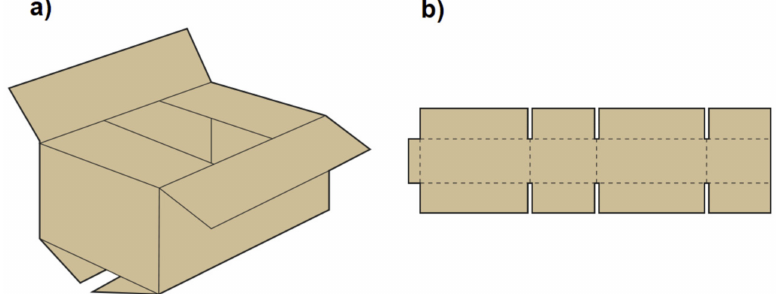
Figure 2. Box type FEFCO 0201 [14]: ( a ) finished box body; ( b ) extended drawing of the box